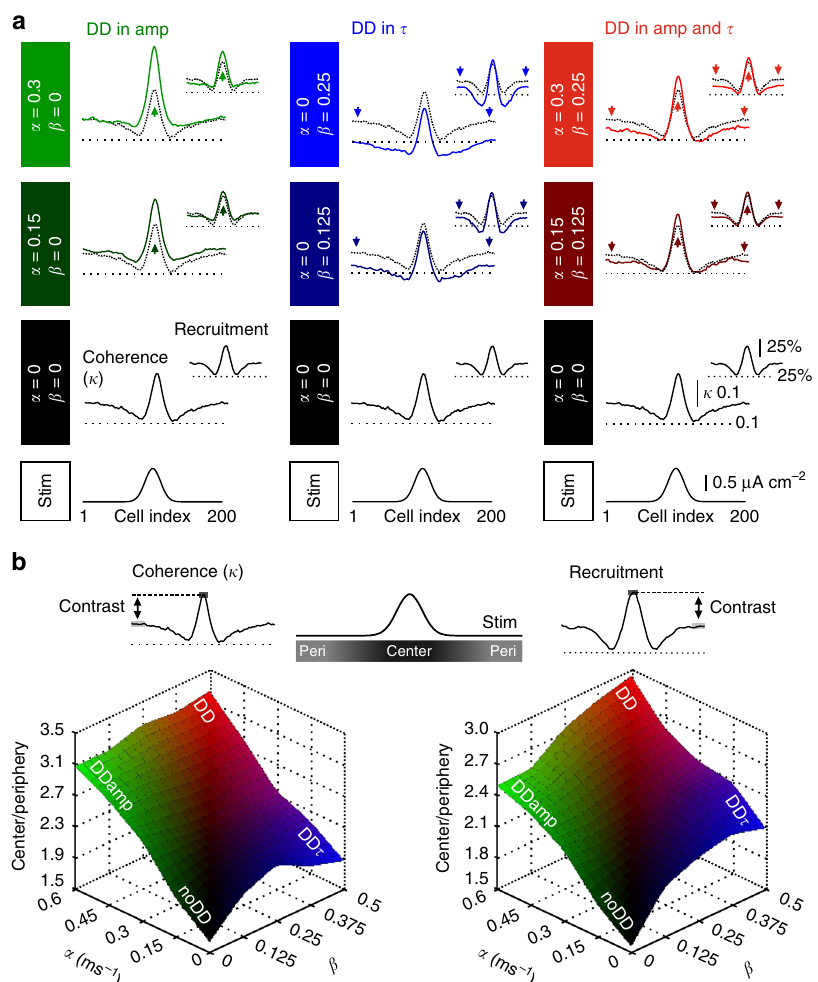
Fig. 5 Distance dependence in amplitude and time course of IPSCs at IN – IN synapses synergistically increases the contrast between center and periphery in an IN network model. a Local analysis of the coherence κ (left traces in each panel) and recruitment (smaller right traces in each panel) over 20 INs at each position in the network. Analysis was performed in the noDD network (black lines in each panel), in the DDamp (left column, green traces), DD τ (middle column, blue traces) and the full DD network (right column, red traces). For each column from bottom to top: Schematic illustrating the focal stimulation to the center of the network. Local κ and recruitment in the noDD network. Comparison of local κ and recruitment in the different DD networks (colored traces) with the noDD network (black dotted traces). Values of the respective DD coef fi cients α and β increase progressively. Arrows indicate dominant effect of distance-dependent inhibition. b Top, schematic illustrates “ center ” (cells #91-110) and “ periphery ” (cells #1-30 and #171-200). Bottom, the center-to-periphery ratio of κ (left) and recruitment (right) was plotted against DD coef fi cients. The noDD network ( α = 0 | β = 0) shows lowest contrast. Note, in combination, distance-dependent amp and τ result in the highest contrast between center and periphery (red). All data are averages